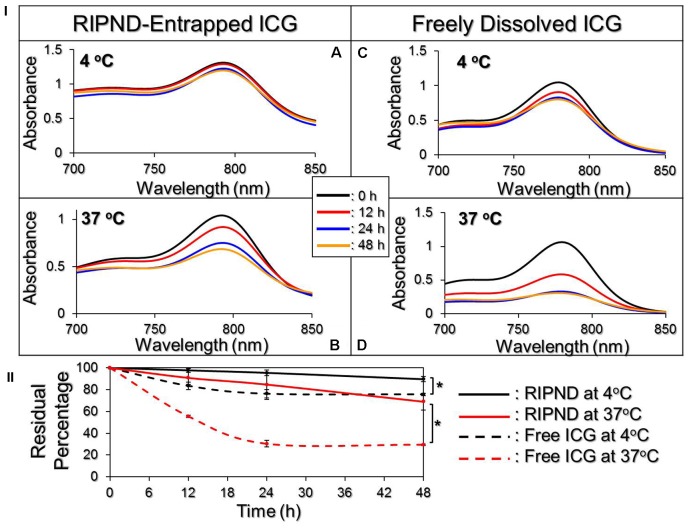
Evaluation of the thermal stability of freely dissolved ICG and RIPND-entrapped ICG. (I) UV-Vis spectra of freely dissolved ICG in DI water (A,B) and RIPND-entrapped ICG (C,D) under 4 (A,C) and 37°C (B,D) without light exposure for 0, 12, 24, and 48 h. The absorbance at λ = 780 nm indicates the amount of ICG remaining in each sample at the time of measurement. (II) Quantitative analyses of residual ICG in the matrix under 4 or 37°C within 48 h. Values are mean ± s.d. (n = 3). ∗P < 0.05.